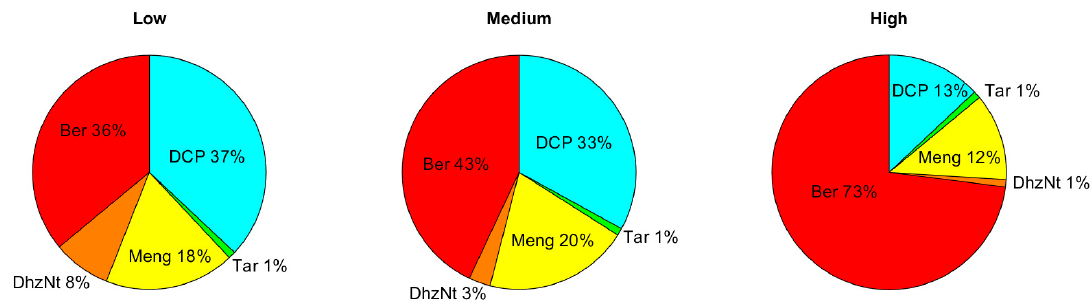
Figure 9. Pie chart with the preference results for each algorithm in each haze condition.